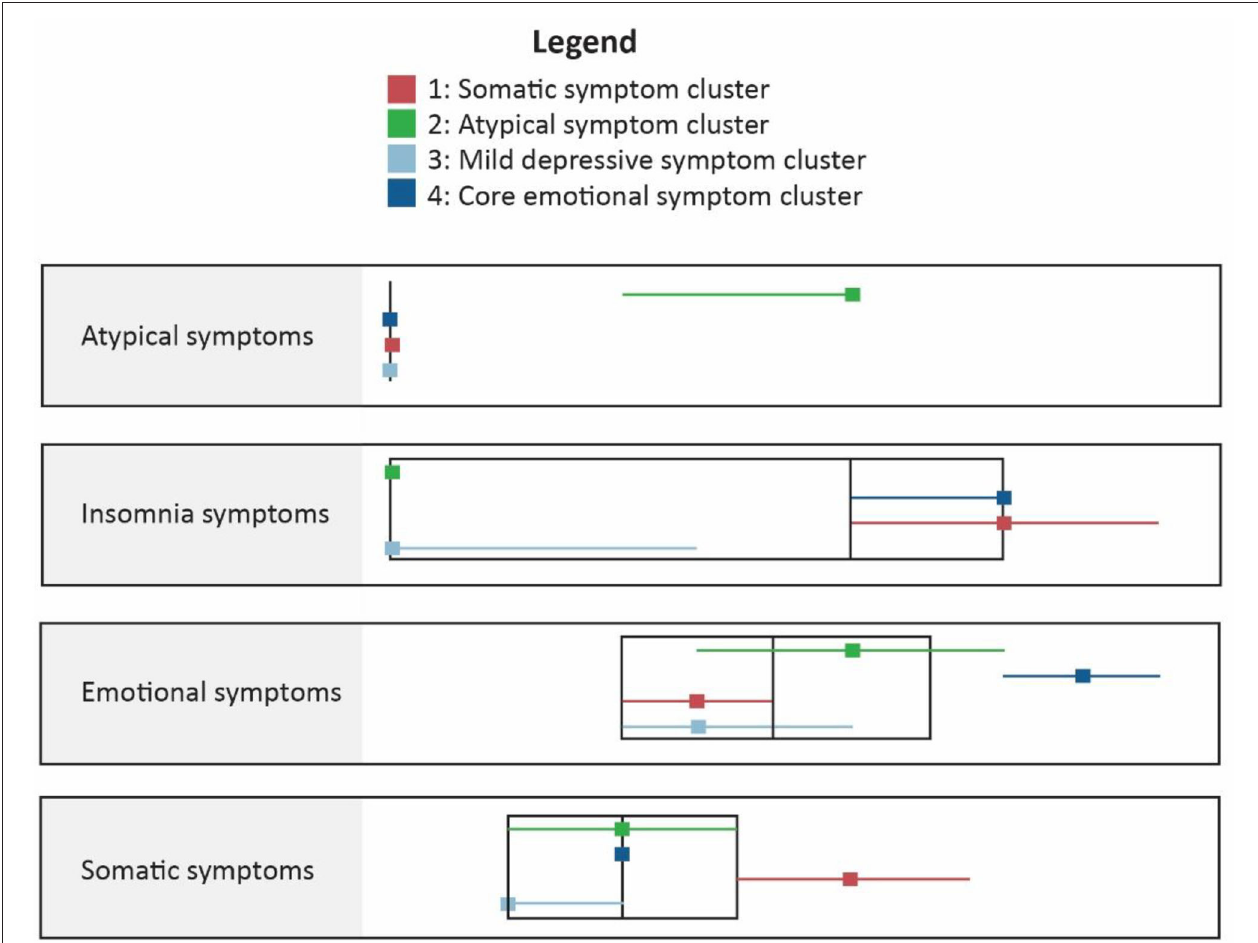
FIGURE 2 | Comparison of clusters on different symptom dimensions in two step clustering